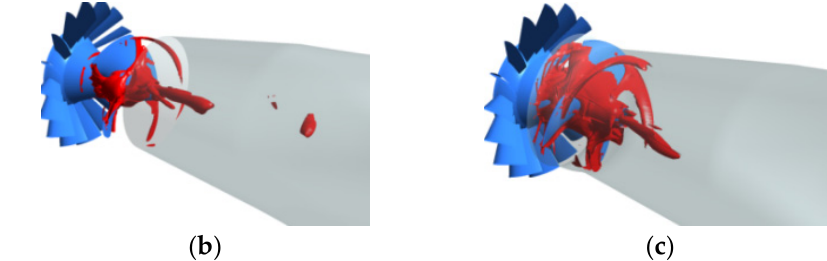
Figure 8. Vortex distribution in tubular turbines: ( a ) Operation condition 1; ( b ) operation condition 2; ( c ) operation condition 3.